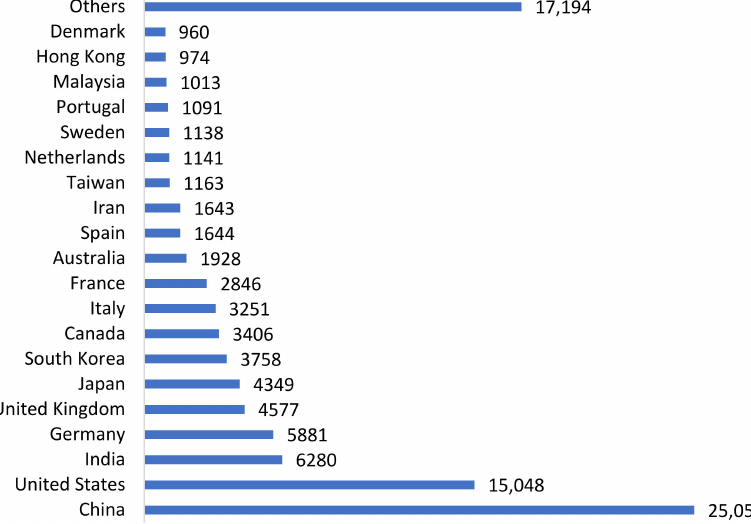
Figure 13. Representation of the 20 countries with the greatest number of authors’ contributions.